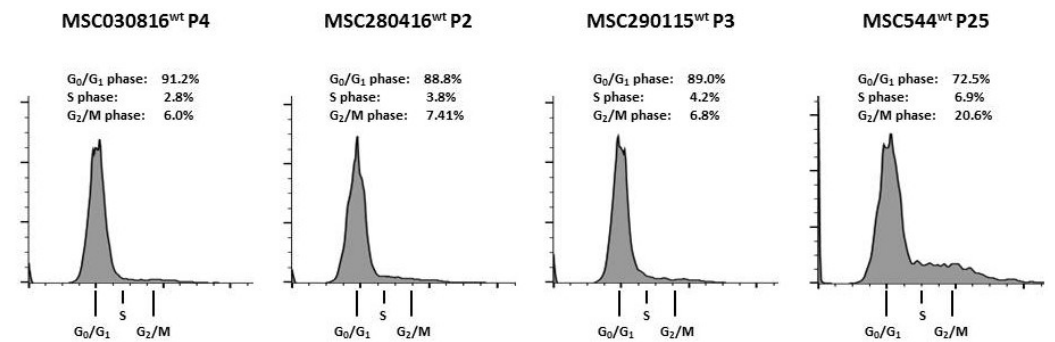
Figure 1. Cell cycle analysis of three different primary human umbilical cord-derived (UC)- mesenchymal stroma-/stem-like cell (MSC) populations in steady state at low passages were compared to the cell cycle progression of MSC544 in steady state at passage 25.